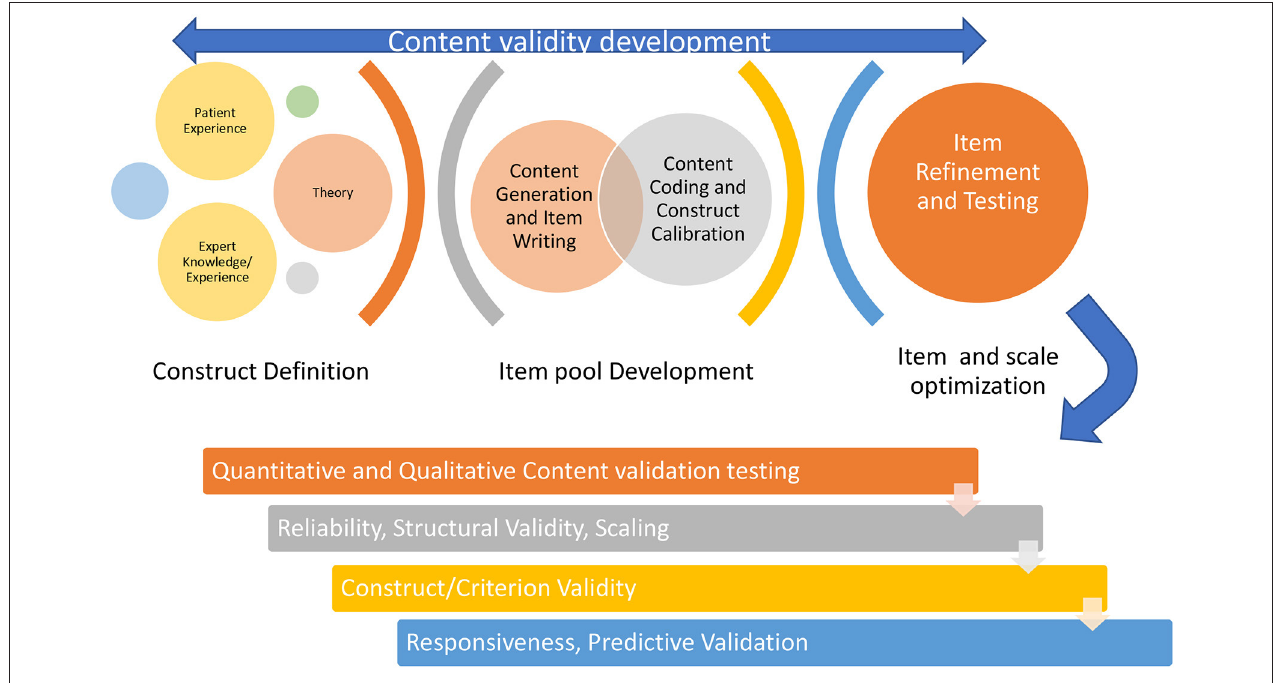
FIGURE 1 | Content validation is a key foundation when developing and evaluating